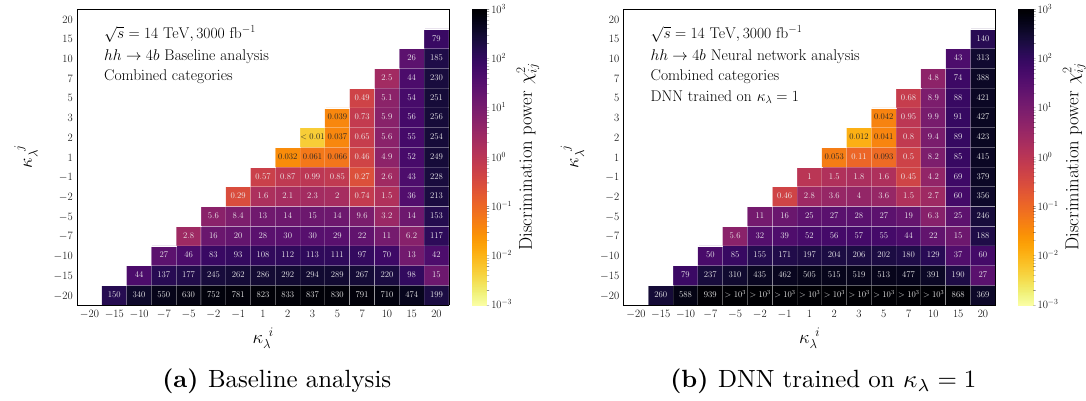
vs λ is calculated from ij